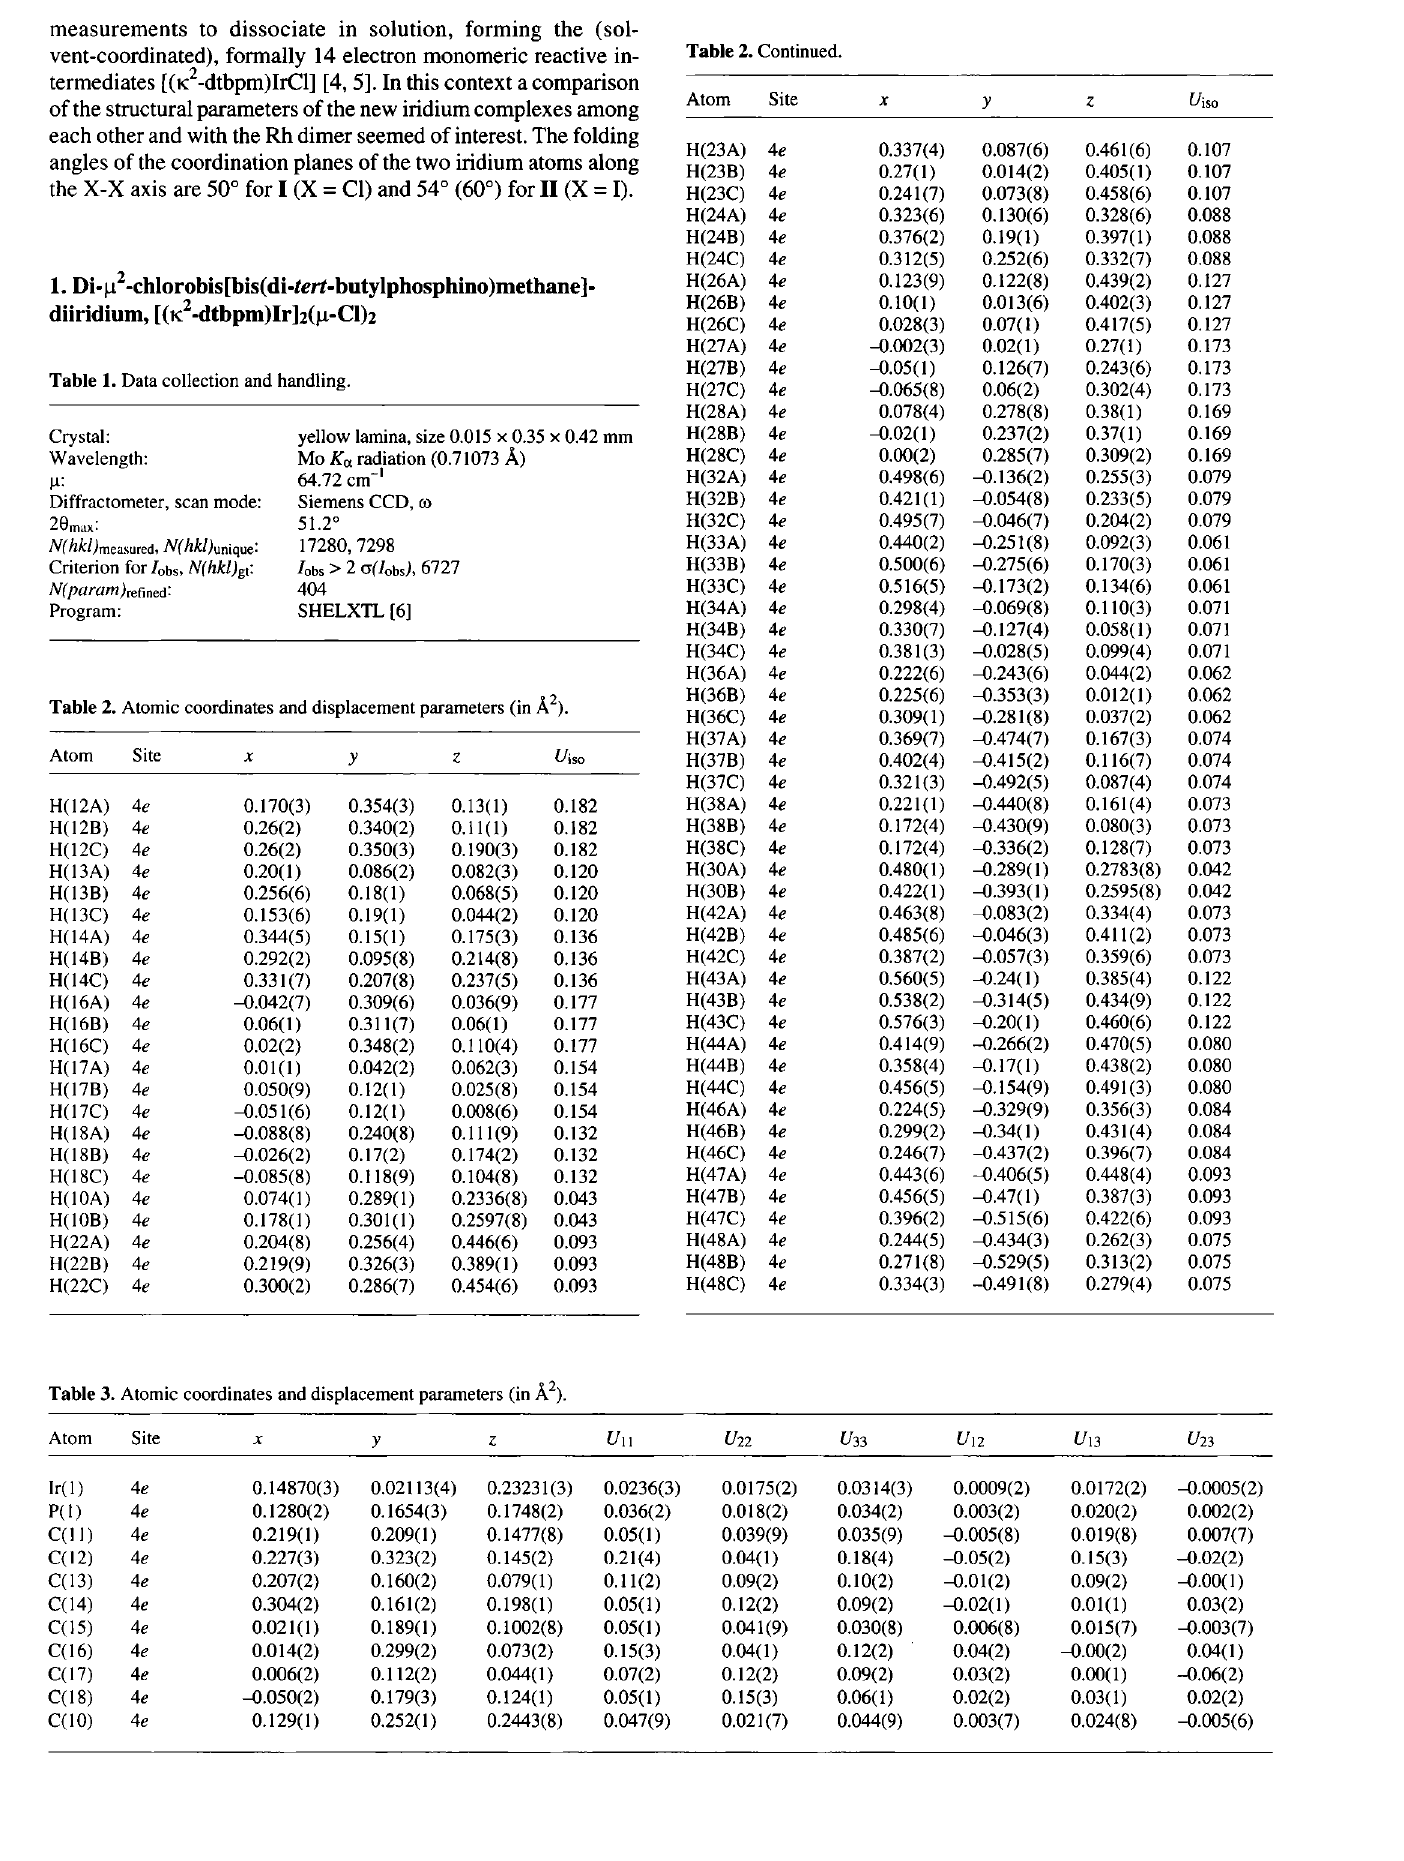
Table 3. Atomic coordinates and displacement parameters (in Â 2